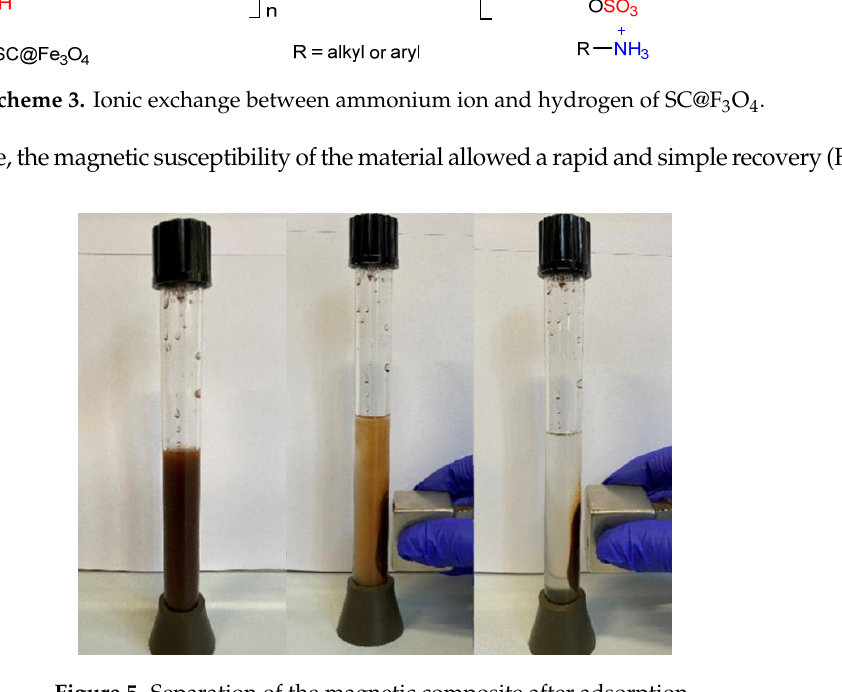
Figure 5. Separation of the magnetic composite after adsorption.